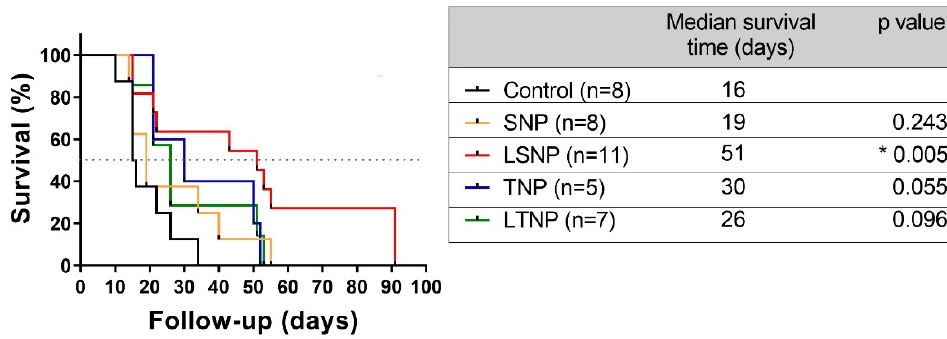
Figure 7. LSNP-induced cytotoxicity is inhibited by the interaction between metabolically conditioned tumor cells. C6 cells were cultured under normoxia and hypoxia for 3 weeks, normoxic cells (glucose 5.5 mM + lactate 32mM, blue bars) and hypoxic cells (glucose 25mM + CoCl 2 320 µM, red bars), and then co-cultured and treated with 100 µg/mL of nanoparticles for 72 h for the evaluation of cytotoxicity with propidium iodide staining. Bars show mean percentage of dead cells ± SEM of two independent experiments in quadruplicate, n = 8 (statistical analysis with one-way ANOVA after logarithmic transformation, * p < 0.001 and ** p < 0.0001 vs. their respective untreated controls).